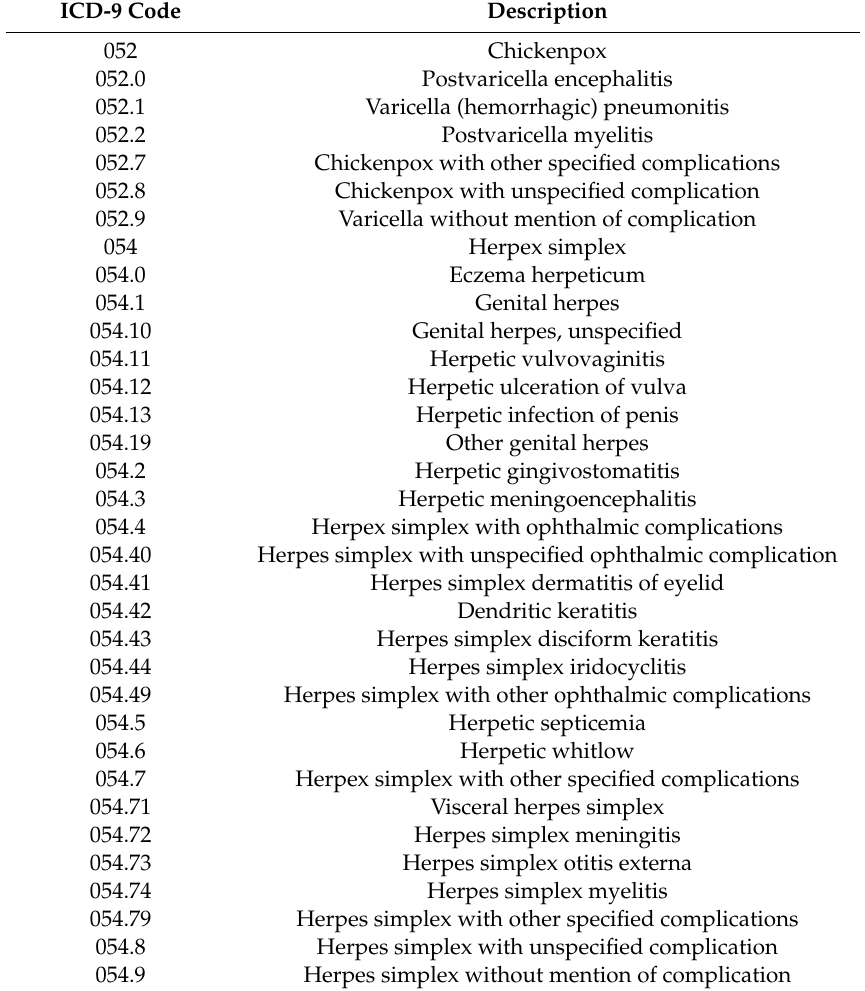
Table A1. International Classification of Diseases (ICD)-9 codes for diseases caused by herpesviruses. ICD-9 Code